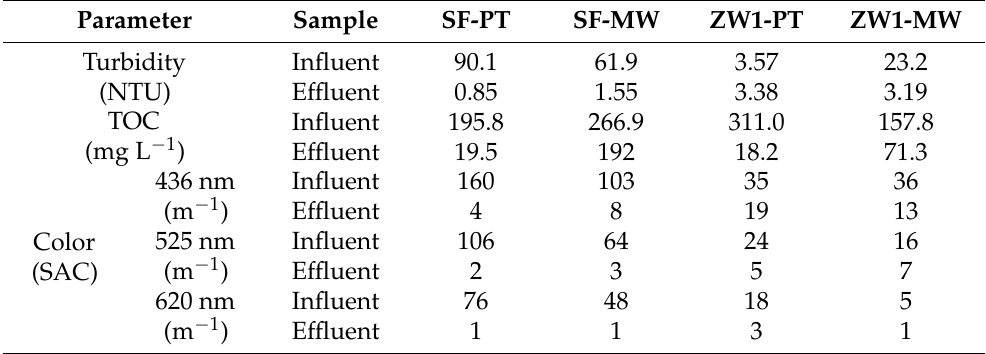
Table 2. Physico-chemical characteristics of SF-PT/MW and ZW1-PT/MW